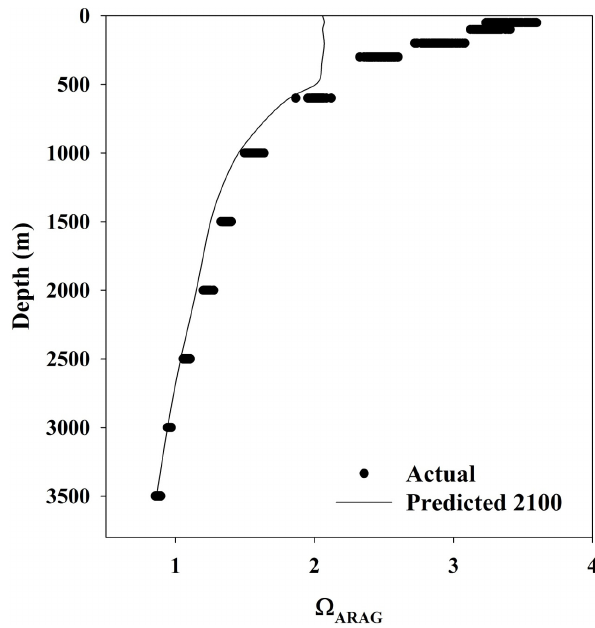
Fig. 7. The average vertical profile of the aragonite saturation state, Fig. 7 (cid:127) Arag for data in the period between 1995–2004 and predicted val- ues for the year 2100 in line with the trends presented in Table 1 for the ten years between 1995–2004.